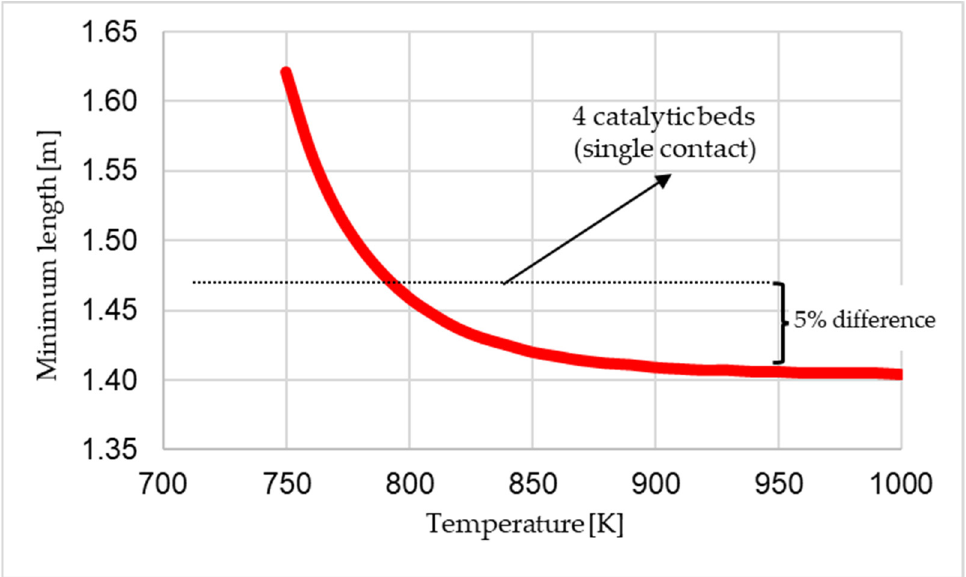
Figure 10. Plot of the minimum length of the catalytic bed as a function of inlet temperature (Sce- nario 11), which is compared with the length of bed of the four catalytic beds for the same optimal